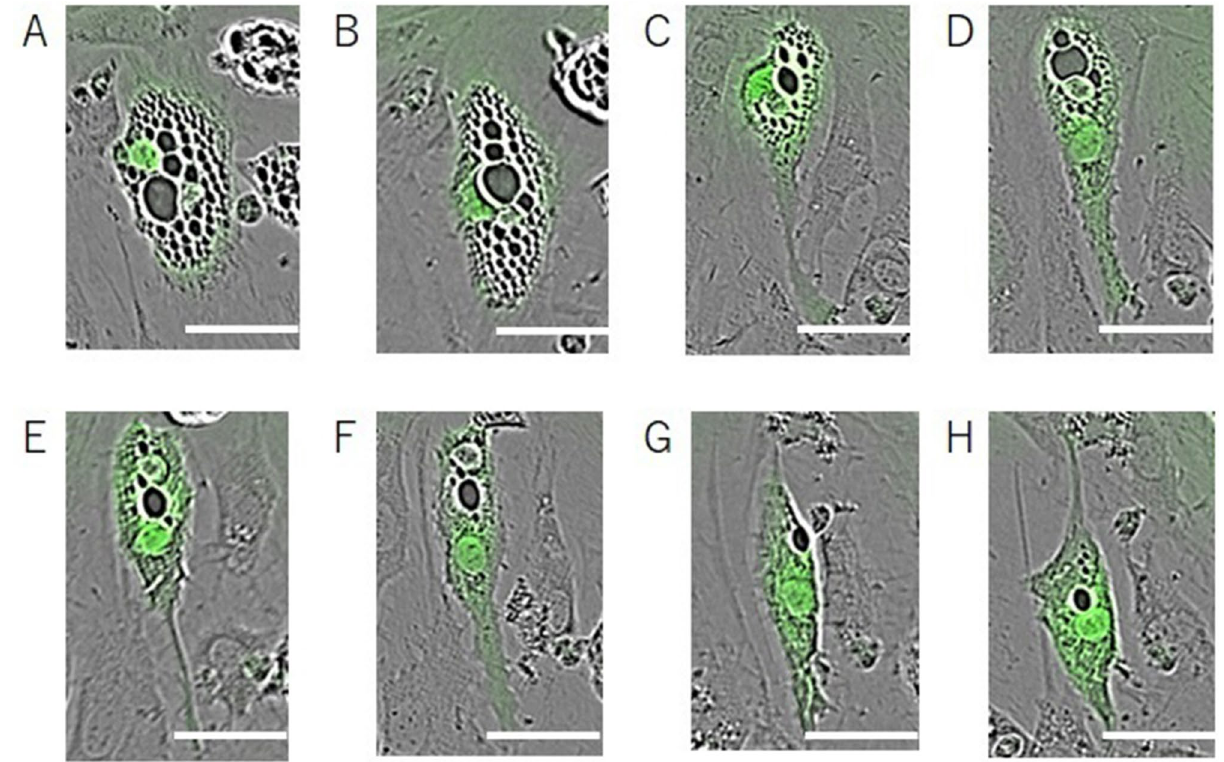
Figure 2. Shape change of infected cells ( A – H ). At 120 h after transfection, no marked change was observed ( A ). After 126 h, cells became vertically elongated ( B ). At 159 h ( C ), 168 h ( D ), 189 h ( E ), and 198 h ( F ) after transfection, the cells were further elongated vertically, and fat droplets were shrunk ( C – F ). After 225 h ( G ) and 237 h ( H ) of transfection, cells became spindle-shaped, just like fibroblasts, and fat droplets almost disappeared ( G , H ). Scale bars, 50